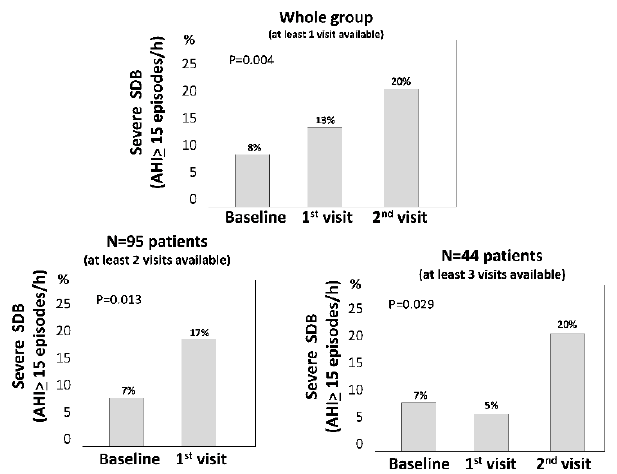
Figure 3. Prevalence of moderate to severe sleep disordered breathing (SDB) across the study in the whole cohort, in patients who had at least 2 visits and in those with at least 3 visits.